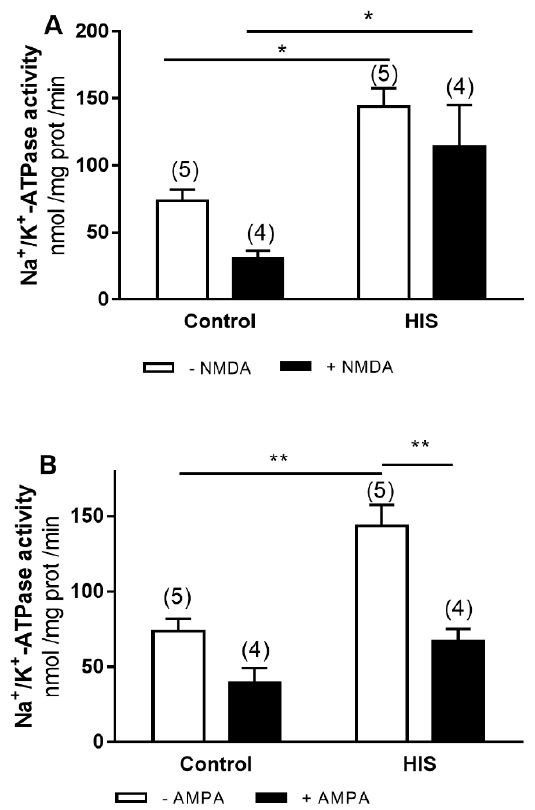
Figure 3. Effects of NMDA ( A ) and AMPA ( B ) activation on Na + /K + -ATPase activity in neonatal cortex 20 days after HIS (PD 32). The activity of Na + /K + ATPase was measured in control rats (PD 32) and after HIS (PD 32), following the protocol described in the Materials and Methods section. To evaluate the influence of NMDA and AMPA receptor activation on Na + /K + ATPase activity, the corresponding plasma membranes were preincubated for 6 min at 30 °C with 140 μ M of NMDA and 140 μ M of AMPA, respectively. Each bar represents the mean ± SEM for 4–5 values. * p < 0.05 and ** p < 0.01 using a two-way ANOVA and Bonferroni’s post hoc test. 2.4. Modulation of Na + /K+-ATPase Activity after HIS by AMPA and Sumanirole in 2-Month- Old Animals The effect of ionotropic glutamate receptor AMPA and G-protein-coupled receptor dopamine D 2 receptor was shown in the Na + /K + -ATPase activity. The two-way ANOVA analyses revealed a significant difference in HIS and agonist AMPA [AMPA: F (1,12) = 17.97, p = 0.0011] (Figure 4A) in Na + /K + -ATPase activity. However, no significative inter- action of HIS x agonist was found. Bonferroni’s post hoc test showed a significant increase in Na + /K + -ATPase activity after HIS in the control group in Figure 4A and B( p < 0.01), with an increase in Na + /K + - ATPase activity in the sumanirole group in Figure 4B ( p < 0.05). In Figure 4B, a decrease was observed in Na + /K + -ATPase activity after HIS in the presence of agonist ( p < 0.05)